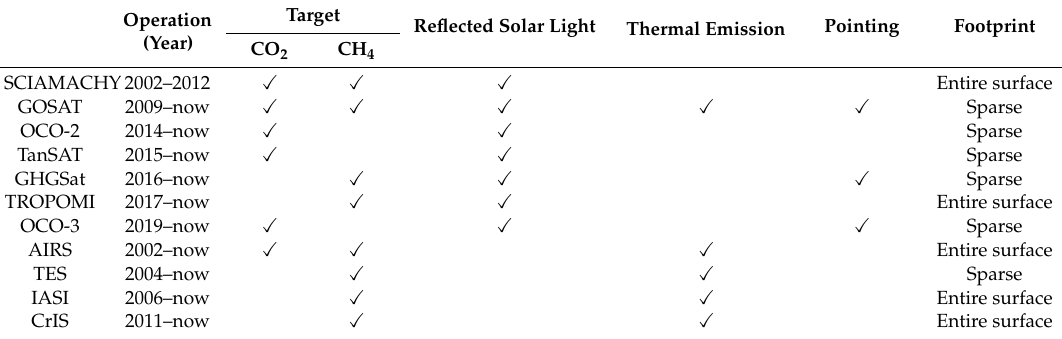
Table 1. Nadir-viewing space-borne